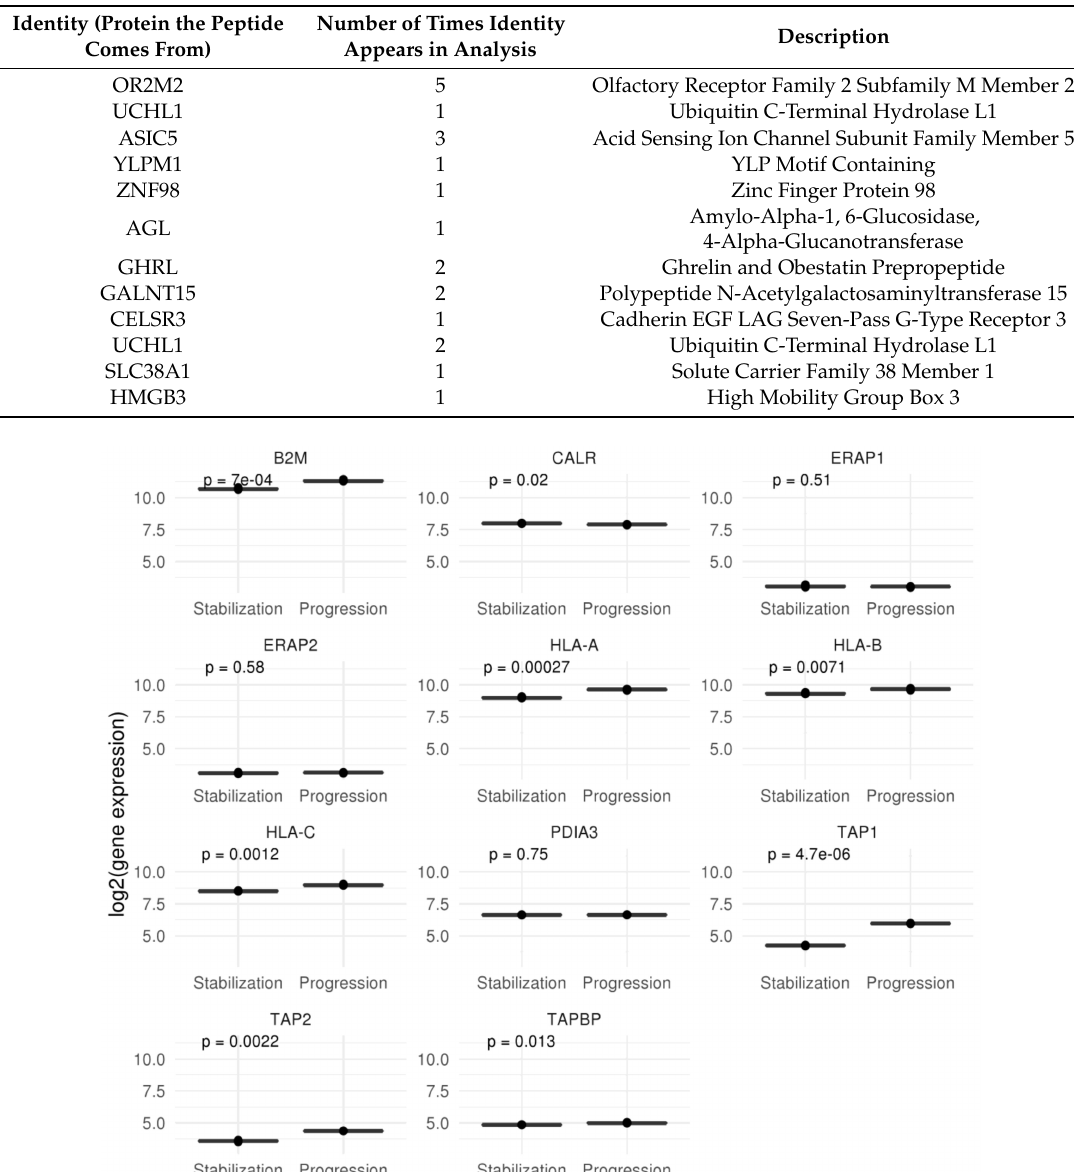
Table 4. Predicted neoepitopes in progression disease.